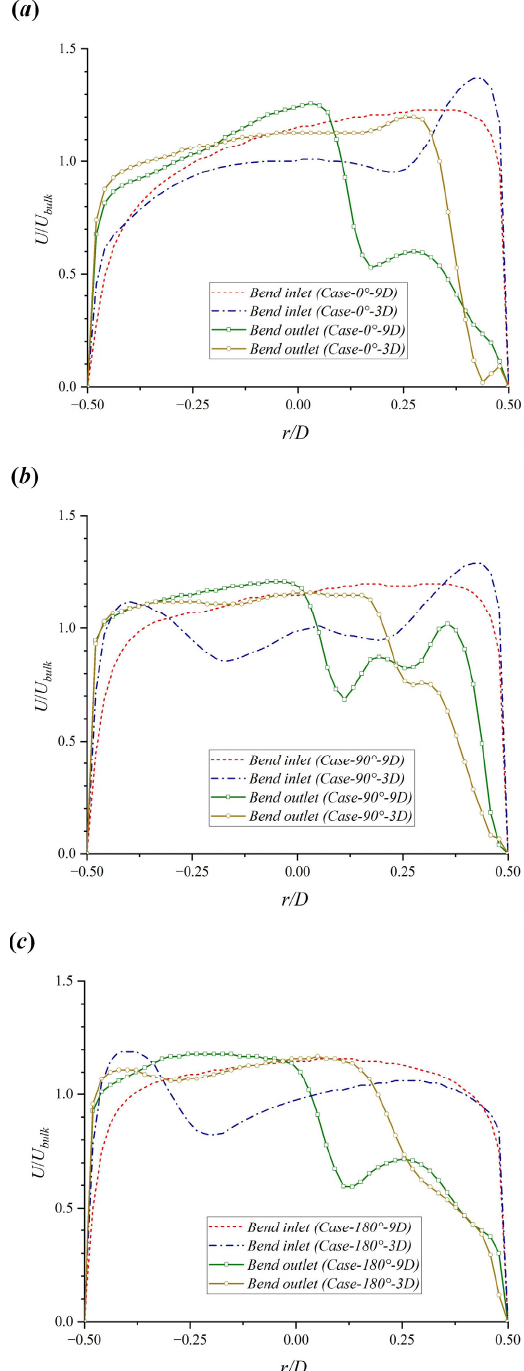
Figure 12. Velocity profiles at inlets and outlets of downstream bends in ( a ) Case-0 ◦ -3D and Case-0 ◦ - 9D ; ( b ) Case-90 ◦ -3D and Case-90 ◦ -9D ; and ( c ) Case-180 ◦ -3D and Case-180 ◦ -9D